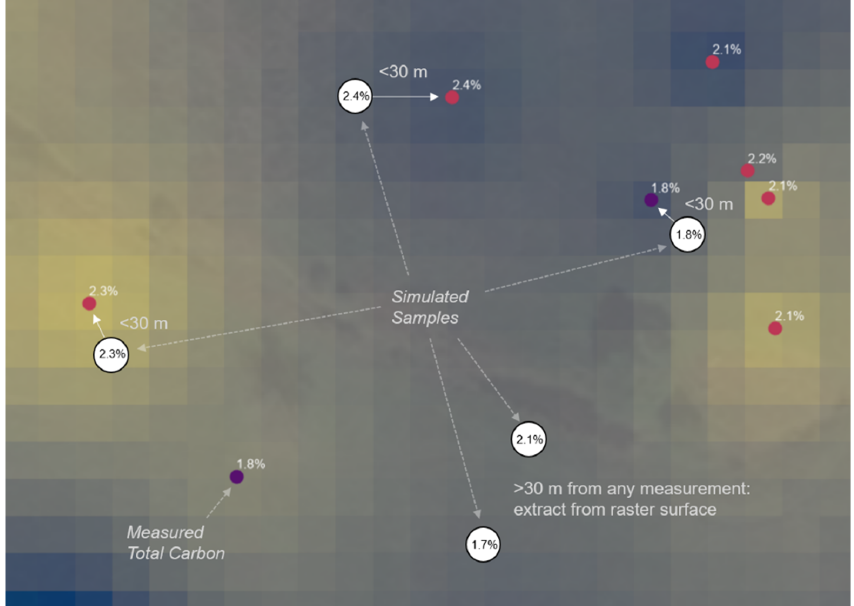
Figure 4. Obtaining carbon values from the nearest known location in simulated sampling. Each of the five points draws its value from the nearest location if within 30 m of a physically sampled site. If further than 30 m, values are assigned to simulated points based on underlying interpolated surface derived from EBK. Dark purple points have lower percent carbon, bright yellow have highest.